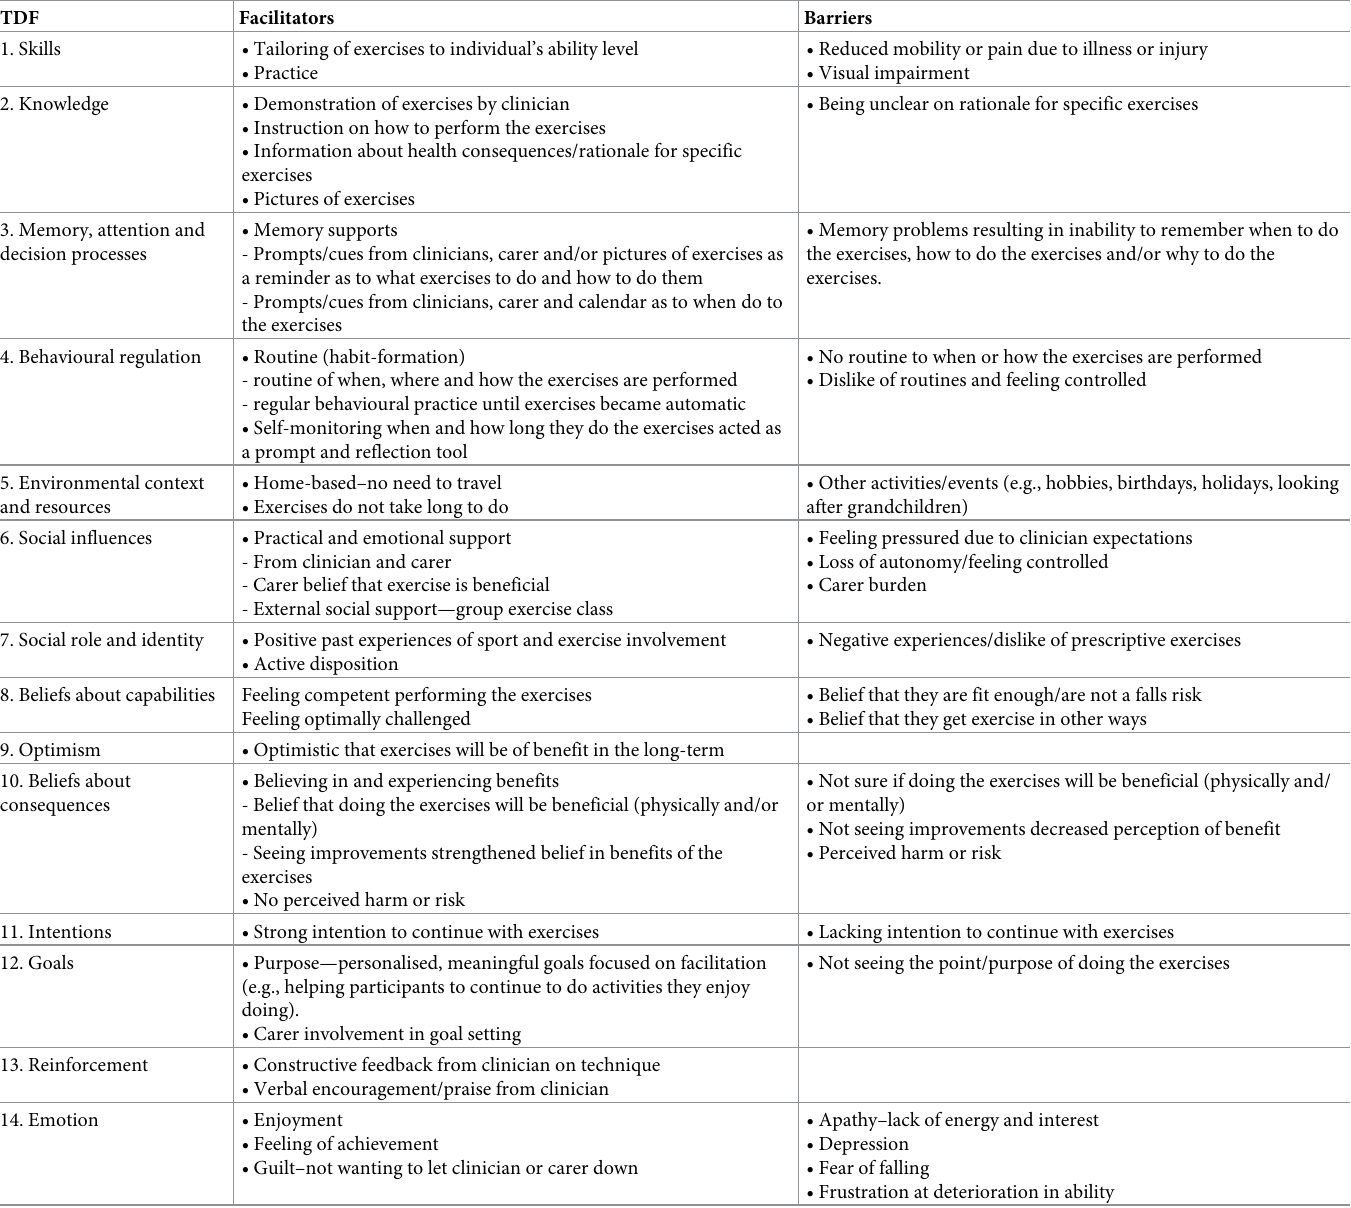
Table 2. Barriers and facilitators perceived to influence adherence to the PrAISED exercises mapped using the Theoretical Domains Framework. TDF Facilitators